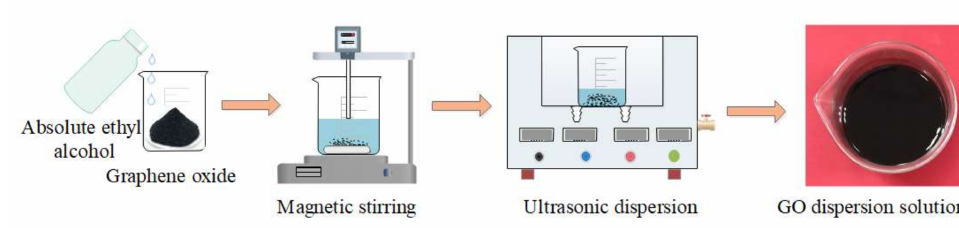
Figure 1. Preparation process of GO dispersion solution.